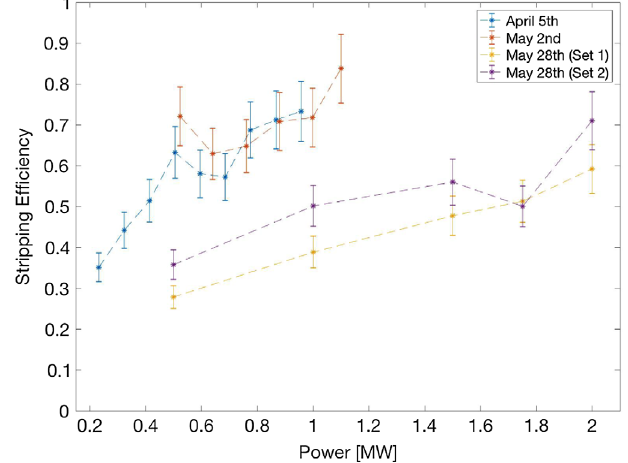
FIG. 25. Stripping efficiency versus laser power.